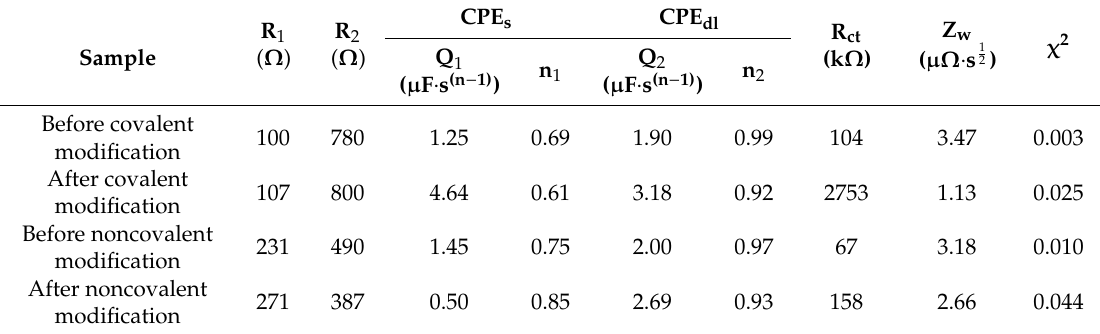
Table 1. Fitting EIS parameters of the graphene electrodes in 0.1 M PBS containing 1 mM FcDA before and after covalent or noncovalent modification.